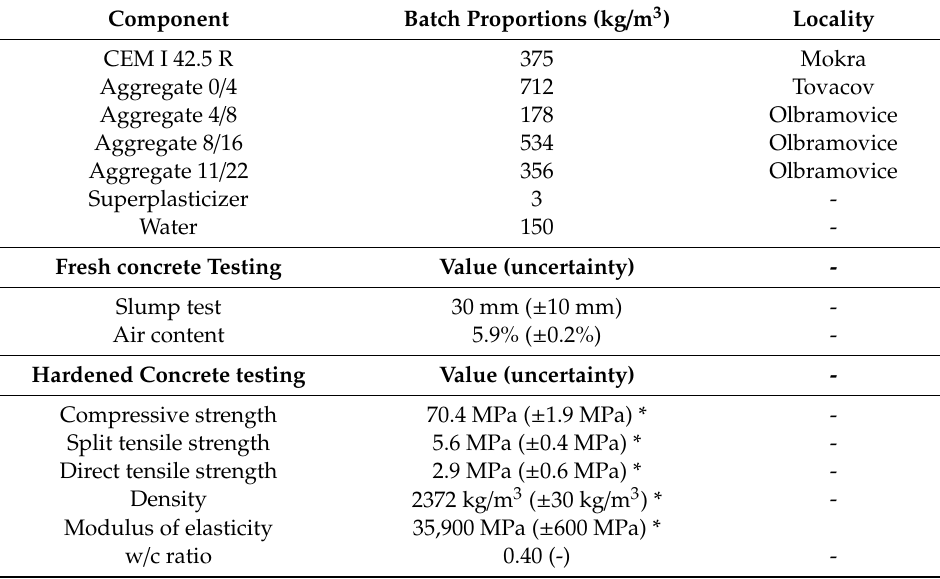
Figure 1. Installation of dowel in steel molds with a plastic partition in the middle and a device for dowel fixation in accurate position before casting for beams “A” (for dimensions of beams 150 × 150 × 350 mm). Table 1. Material parameters of